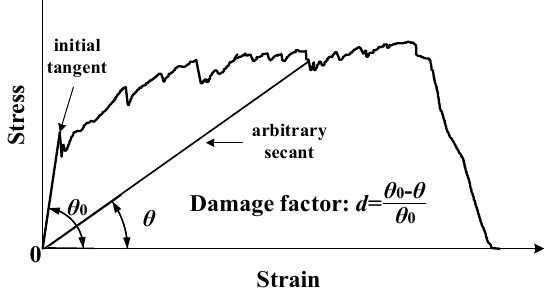
Figure 5. The definition of damage factor of ECC in this paper.